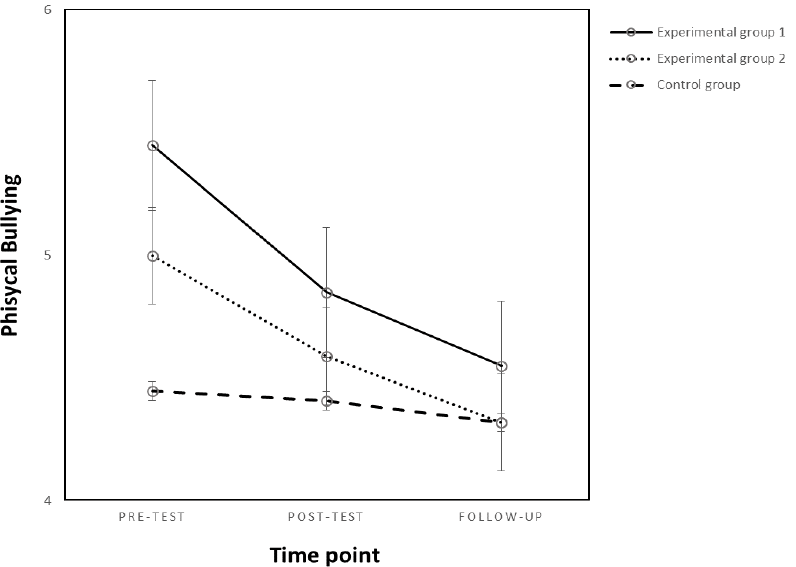
Figure 3. Changes in physical bullying as an effect of the experimental condition and time point.